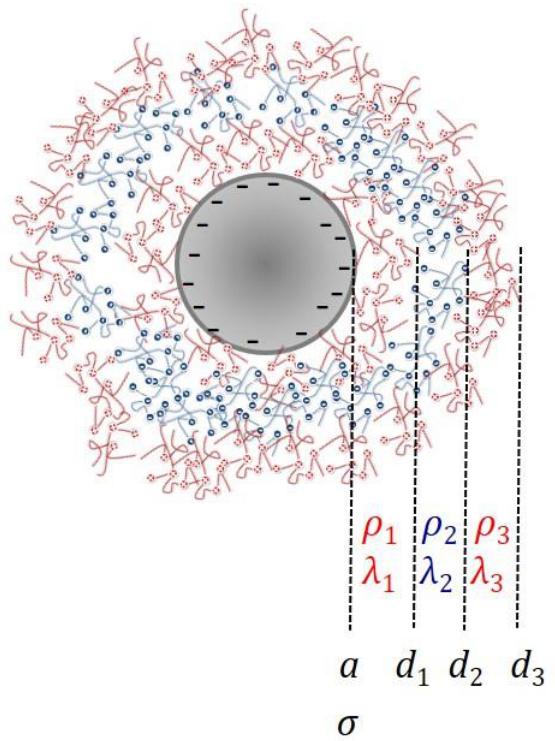
Figure 1. Schematic representation of a multi-layered soft particle (core radius: a ; core surface charge density: σ ; layer thickness: d i ; layer volume charge density: ρ i ; friction coefficient of the i -th layer: λ i ).